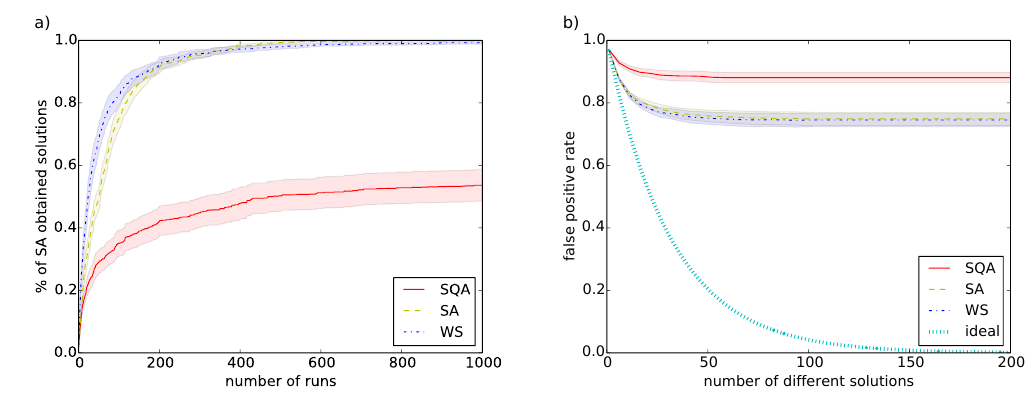
Figure 14: The plots are averaged over 20 randomly generated 5-SAT instances with n = 48 ≈ 19.6. In a) a normalized average of the variables and a clauses-to-variables-ratio of α χ 5 different solutions is shown and in b) the FPR is shown.